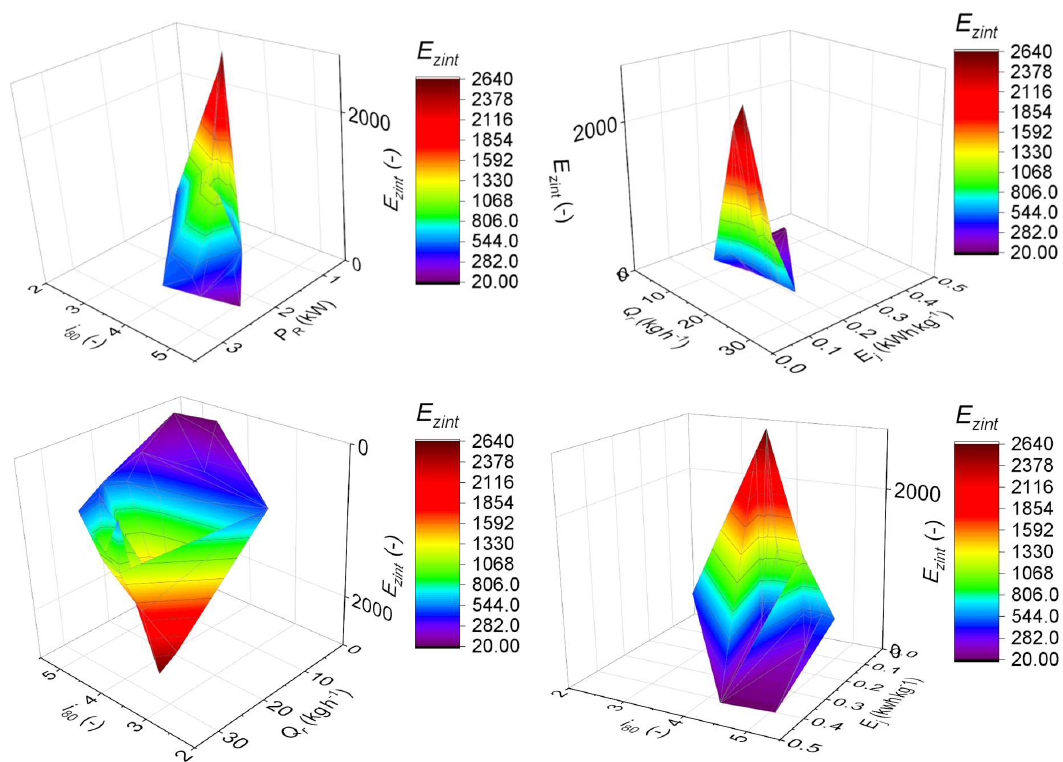
Figure 13. The integrated energy consumption for corn grinding as a function of the model variable components.